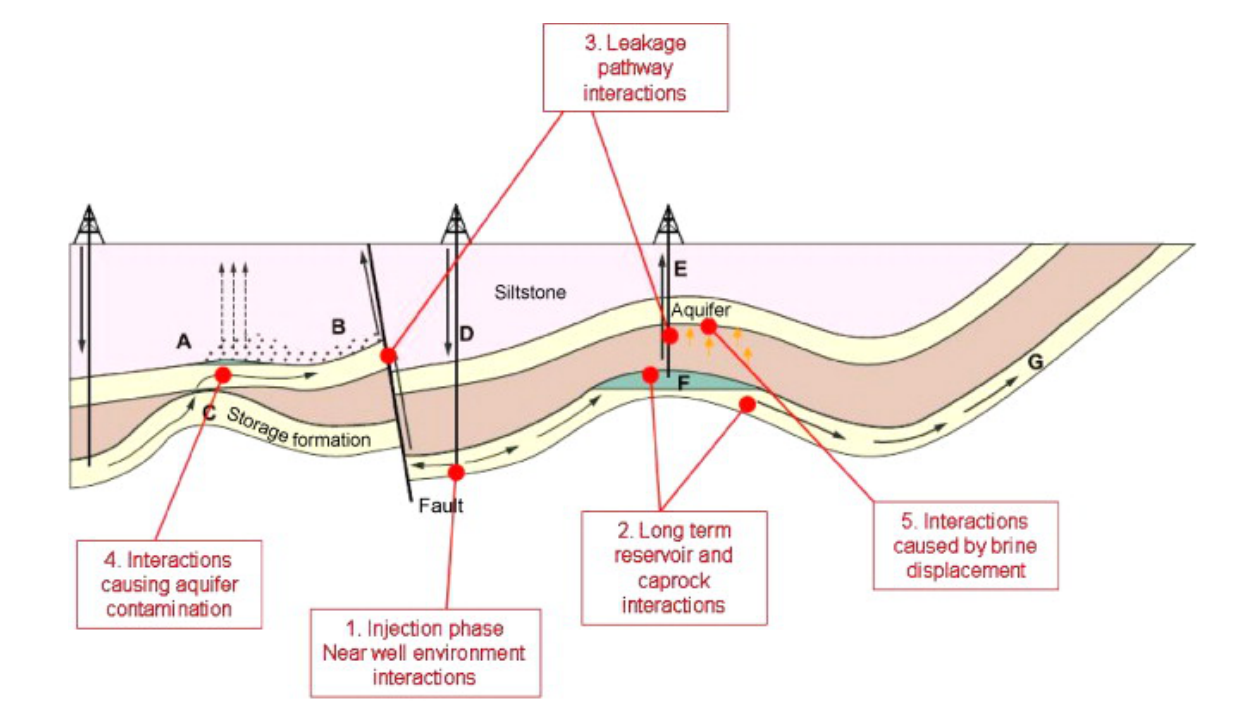
Figure 2. Summary of potential CO 2 injection schemes and various CO 2 –rock interactions. Reprinted from Gaus [19]. Copyright (2010), with permission from Elsevier.